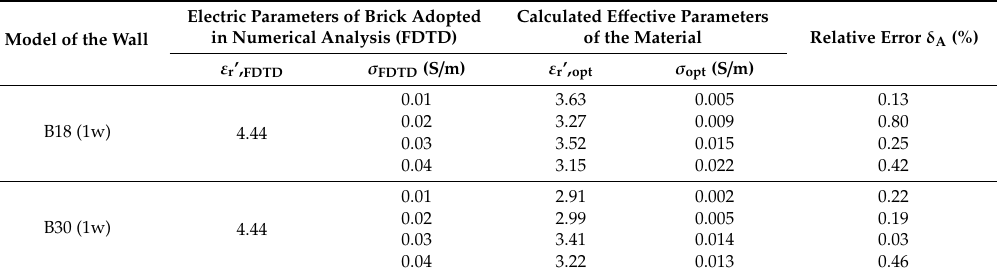
Table 4. Calculated e ff ective electric parameters, double-layer wall (B18 and B30). Electric Parameters of Brick Adopted in Numerical Analysis Model of the Brick Table 3. Calculated effective electric parameters, one-layer wall (B18 and B30).